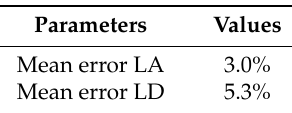
Figure 22. The blue graph is the error between the simulated value and the real value. The red dotted line is the mean value of the error between the real measure and the simulated one. ( a ) Values of the measure of l A ; ( b ) Values of the measure of l D .